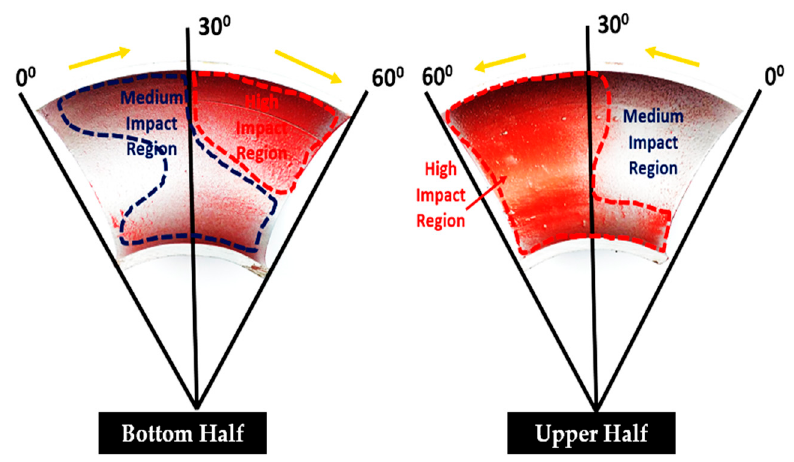
Figure 7. Erosion pattern on the 60° elbow coated with a two-layer paint.